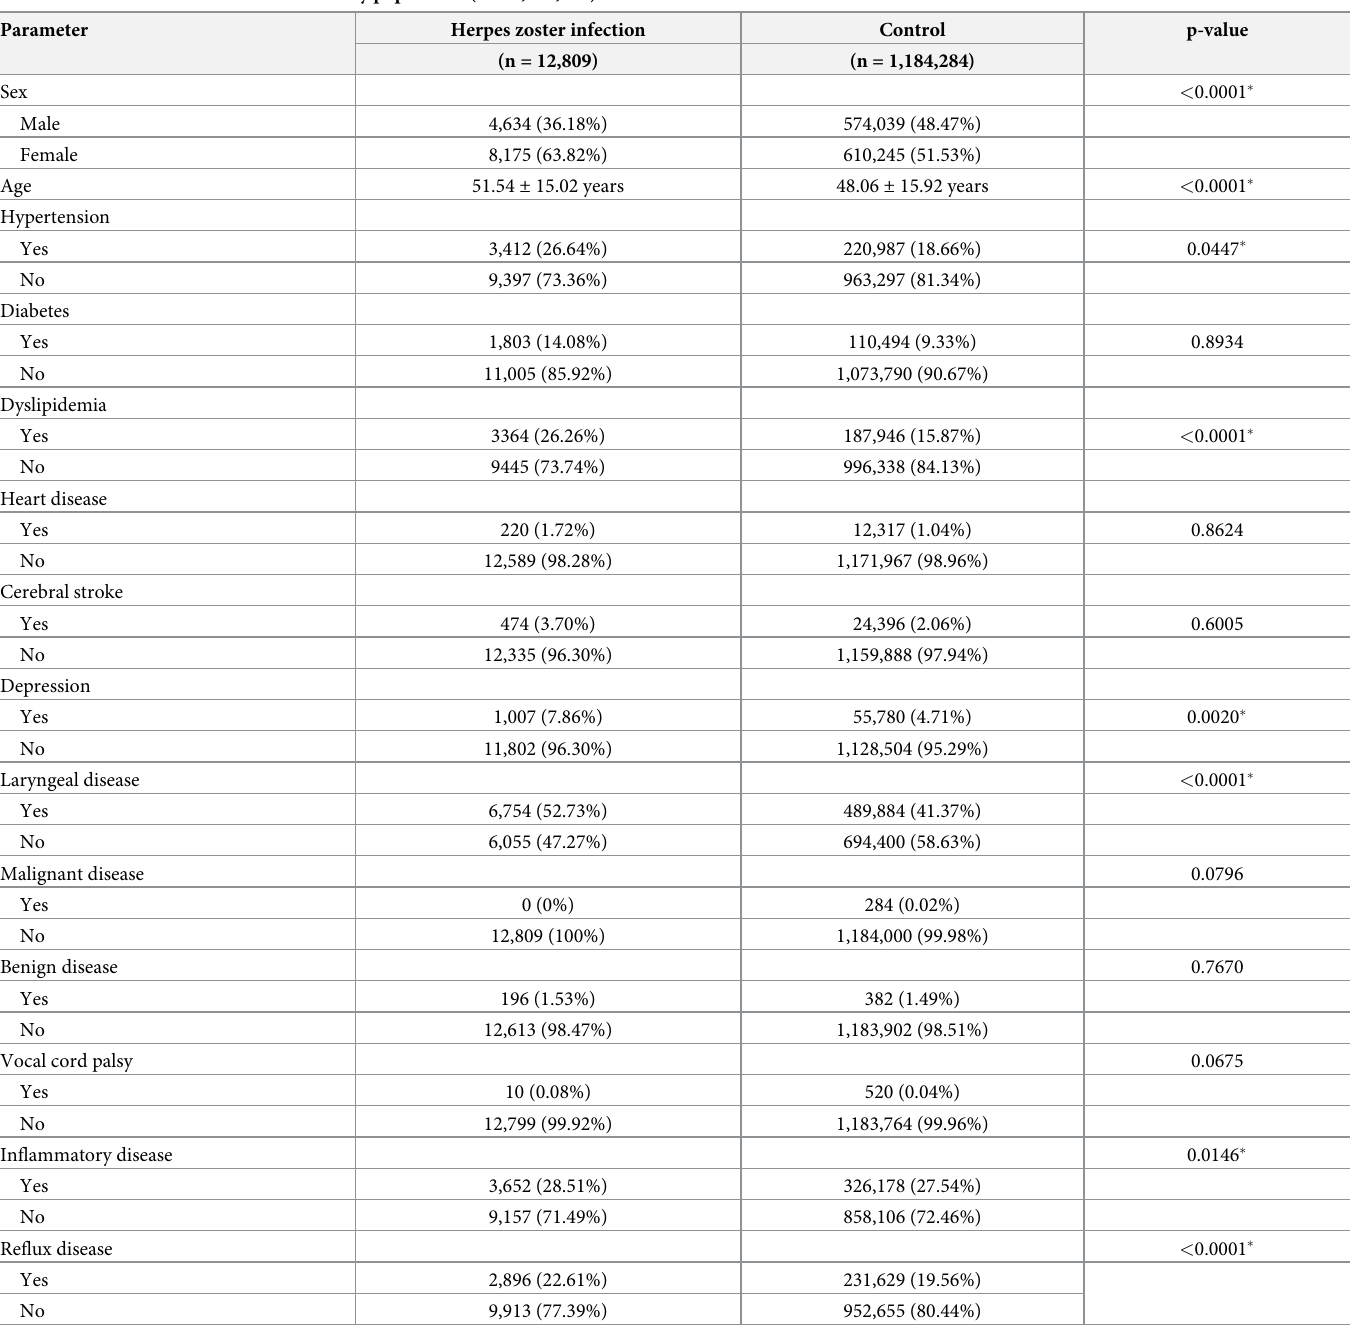
Table 1. Baseline characteristics of the study population (N =